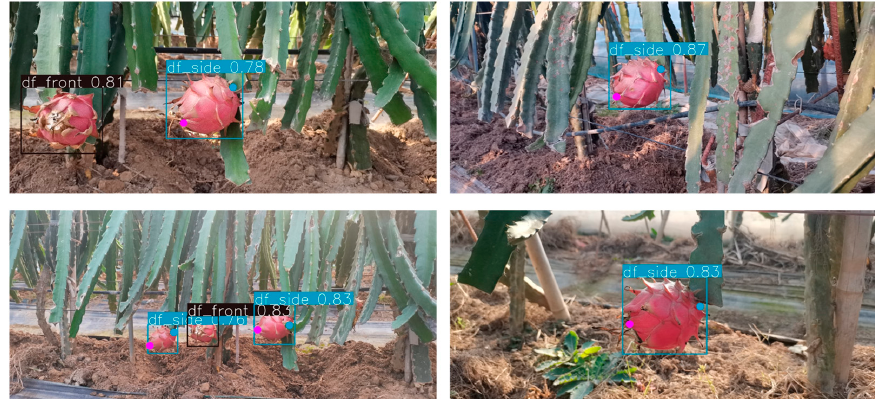
Figure 8. Dragon fruit detection results of the method proposed in this paper. df_front denotes DF_F and df_side denotes DF_S.